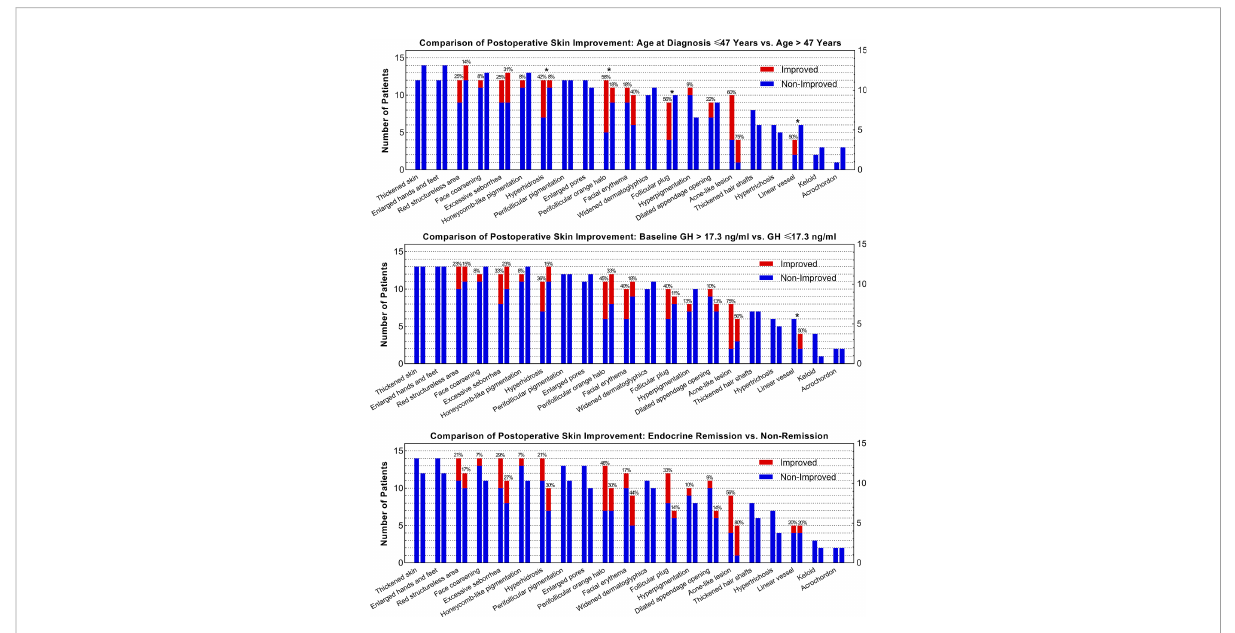
FIGURE 3 Comparisons of the Improvement Rate of Each Skin Lesion between Subgroups as Strati fi ed by Age, Baseline GH Level, and Remission Status. * Indicates that the difference of the improvement rates of skin lesions between subgroups is over